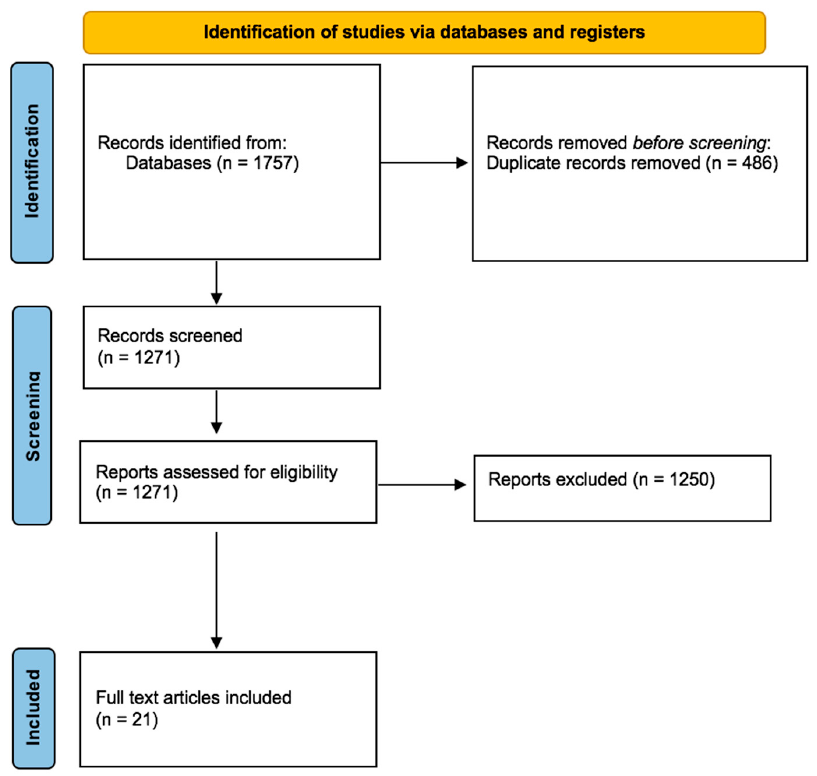
Figure 1. Flow diagram illustrating included and excluded studies in this systematic